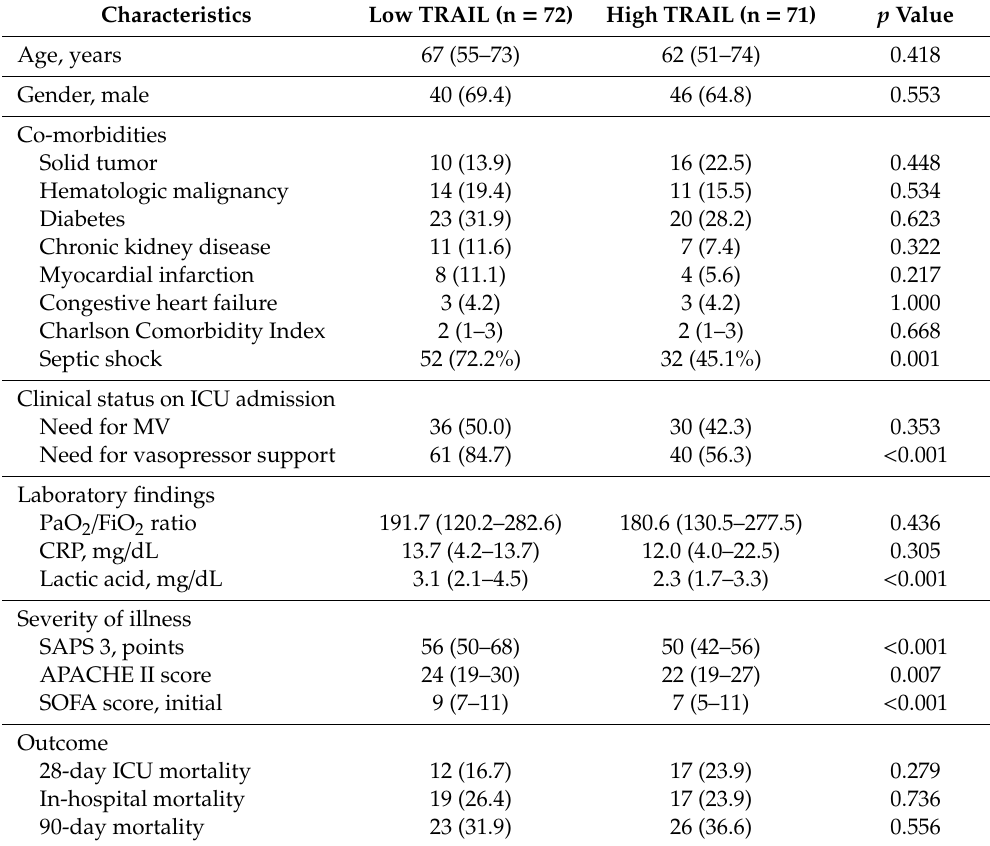
Figure 3. Correlation between plasma level of TRAIL and RIPK3 in patients with sepsis (n = 143).